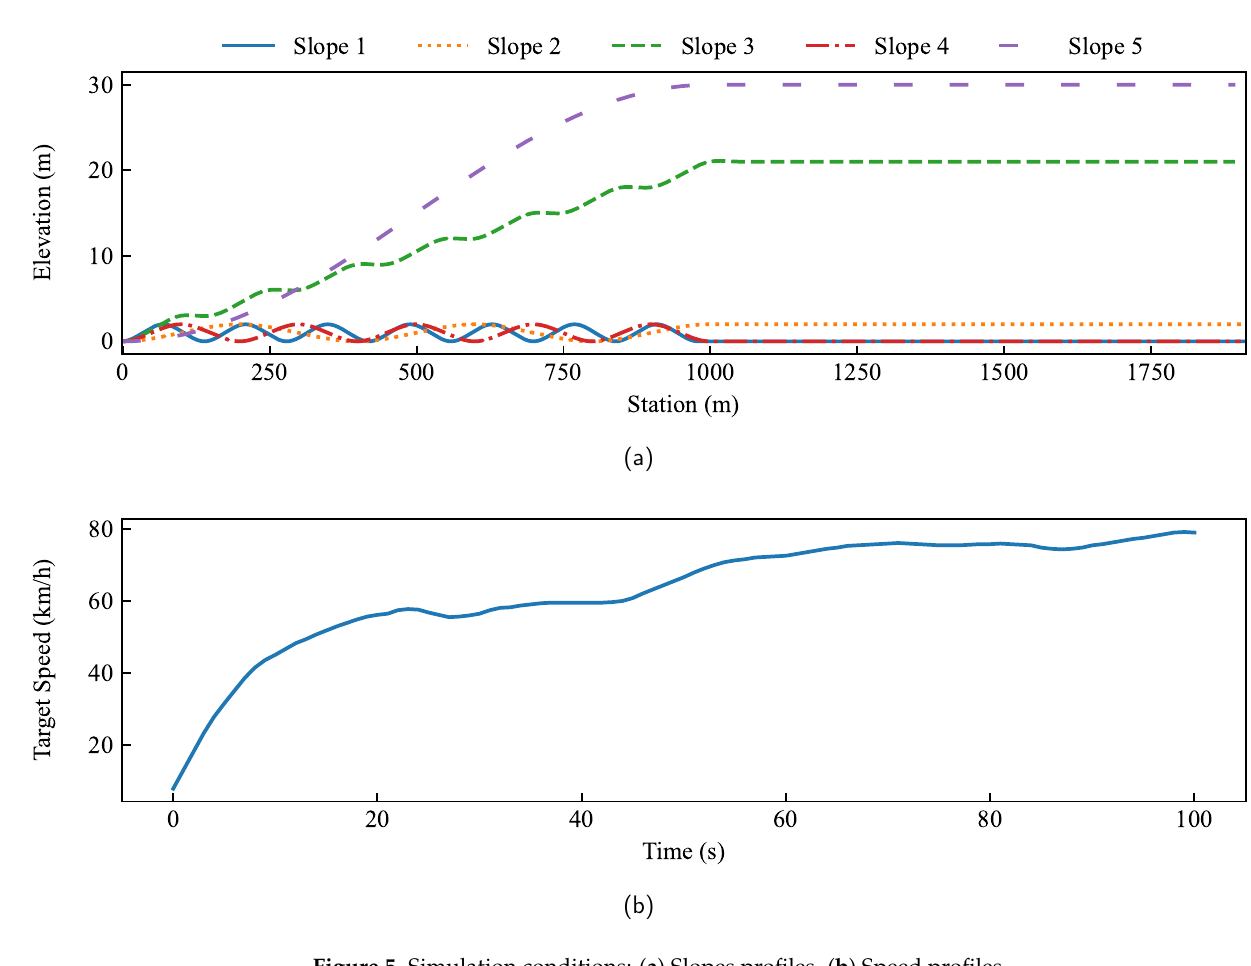
Figure 5. Simulation conditions: ( a ) Slopes profiles. ( b ) Speed profiles.